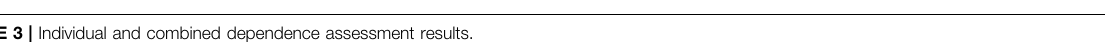
TABLE 3 | Individual and combined dependence assessment results.